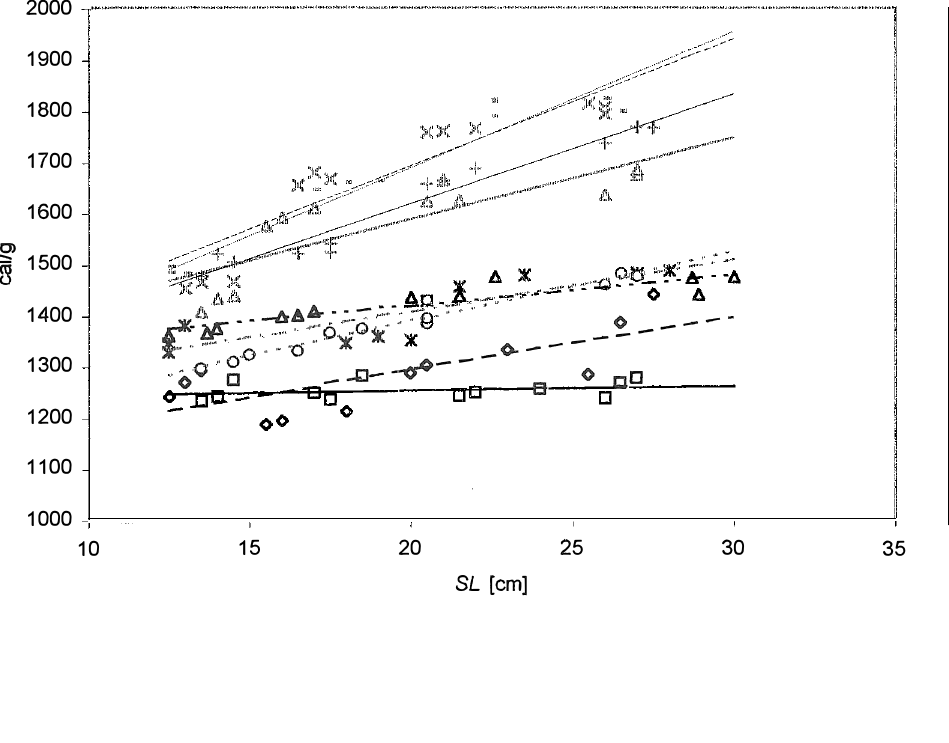
Fig. 5. Seasonal changes in fish-length dependent body calorific value